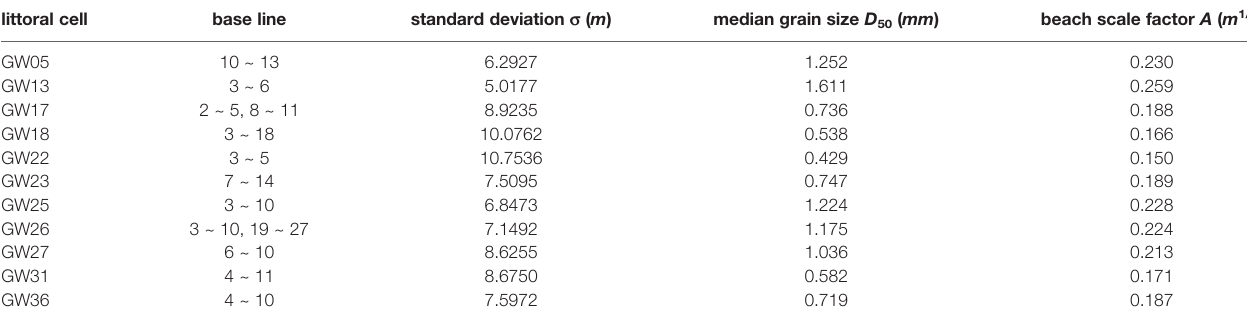
TABLE 3 | Averaged standard deviation of shoreline change and averaged median grain size on the littoral cells of straight shoreline-type. littoral cell